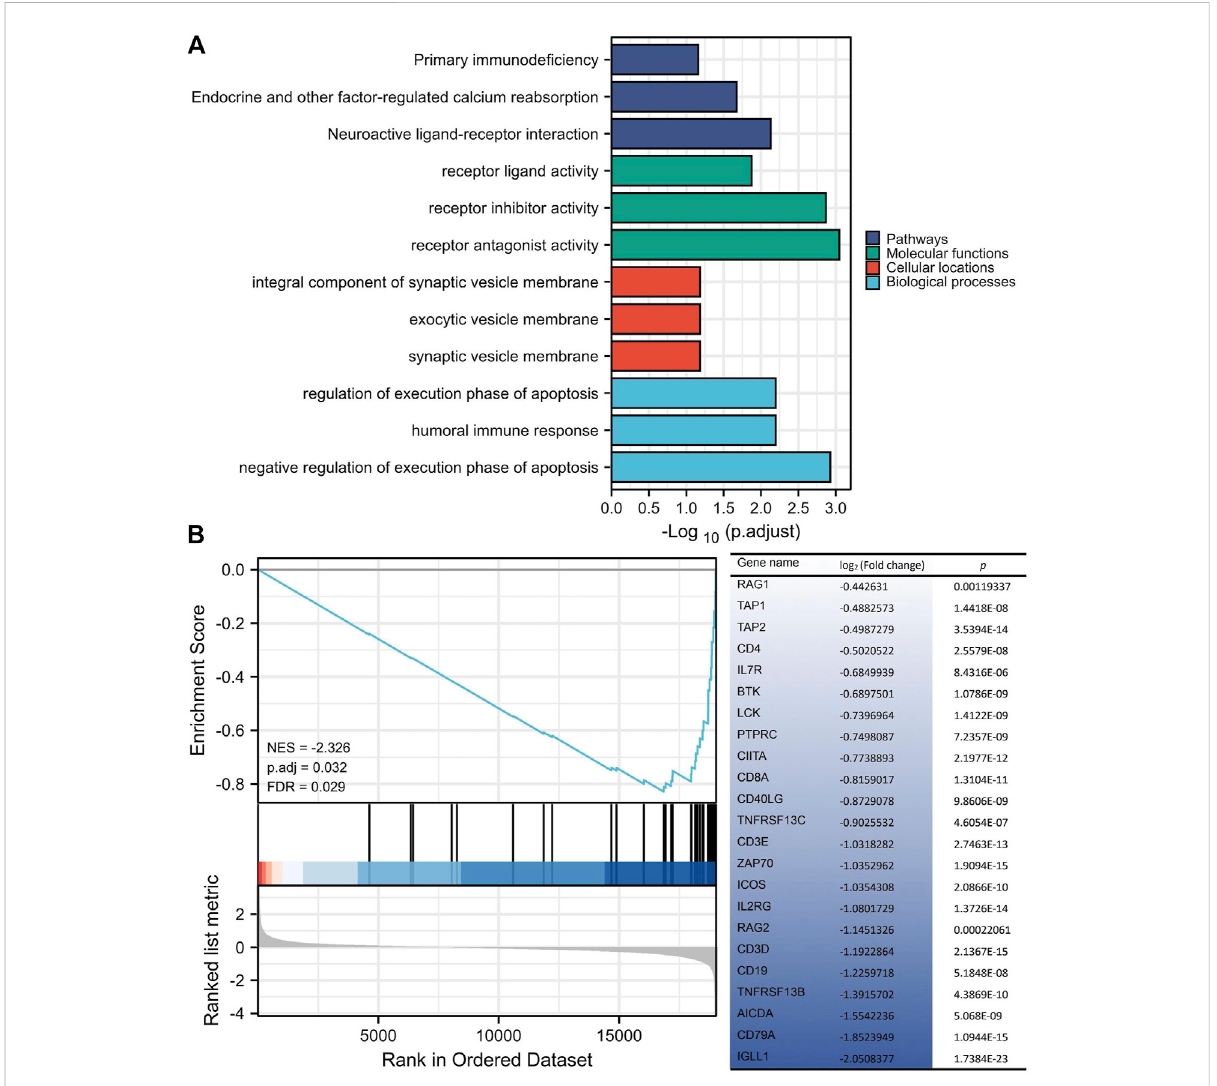
FIGURE 7 KEGG and GO enrichment analysis of differentially expressedgenes between high and low expression of ERBB2 groups. (A) 146 ERBB2-related differentially expressed genes were enriched in KEGG signaling pathways and GO annotations, such as the primary immunode fi ciency. (B) GSEA analysis of 19433 protein-coding genes and 146 ERBB2-related differentially expressed genes showed that the genes involved in the primary immunode fi ciency pathway were mainly 23 down-regulated genes in the ERBB2 high expression group; Gene expression was sorted by log 2 (fold